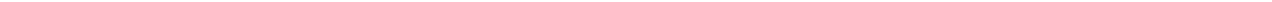
ethnicity and BMI. A sample description is in Supplementary Table 1. Table 1 describes MRI-derived fat measures according to diagnostic status. There were no signi fi cant differences between groups in total fat ( d = 0.00, 95% CI: − 0.46 – 0.46; p = 1.00),